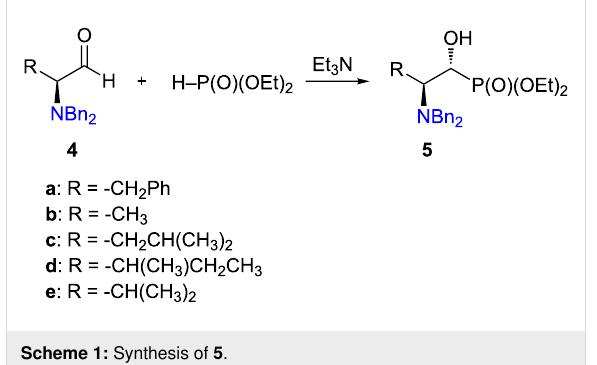
Scheme 1: Synthesis of 5 .